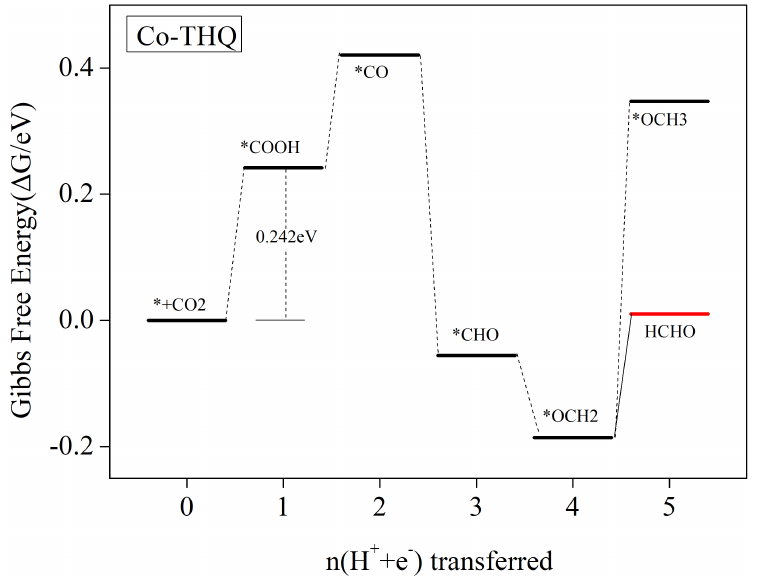
Figure 7. Gibbs free energy profile of CO 2 RR at zero potential along the most favorable route of Co-THQ. In the aseous stage, the free energy of a CO 2 molecule with a clean catalytic surface is